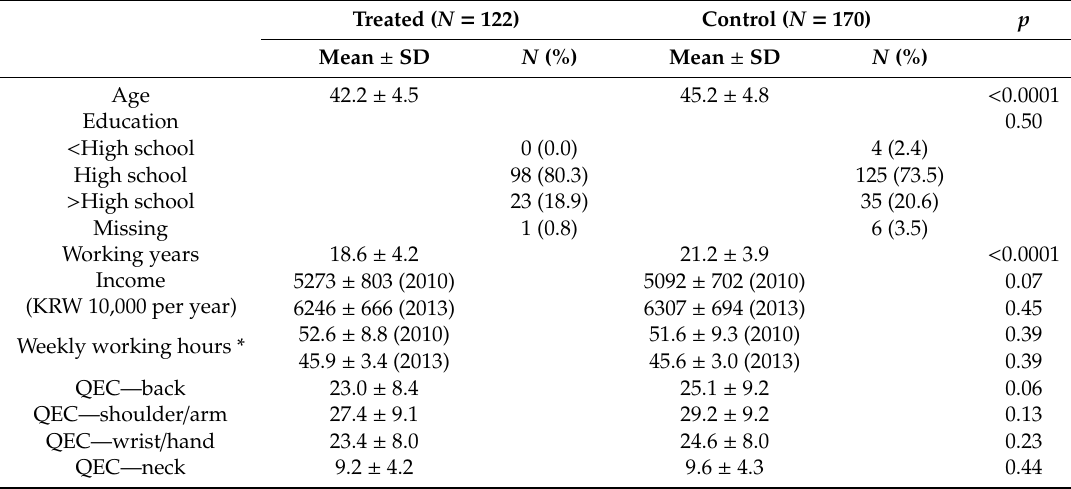
Table 1. Characters of study